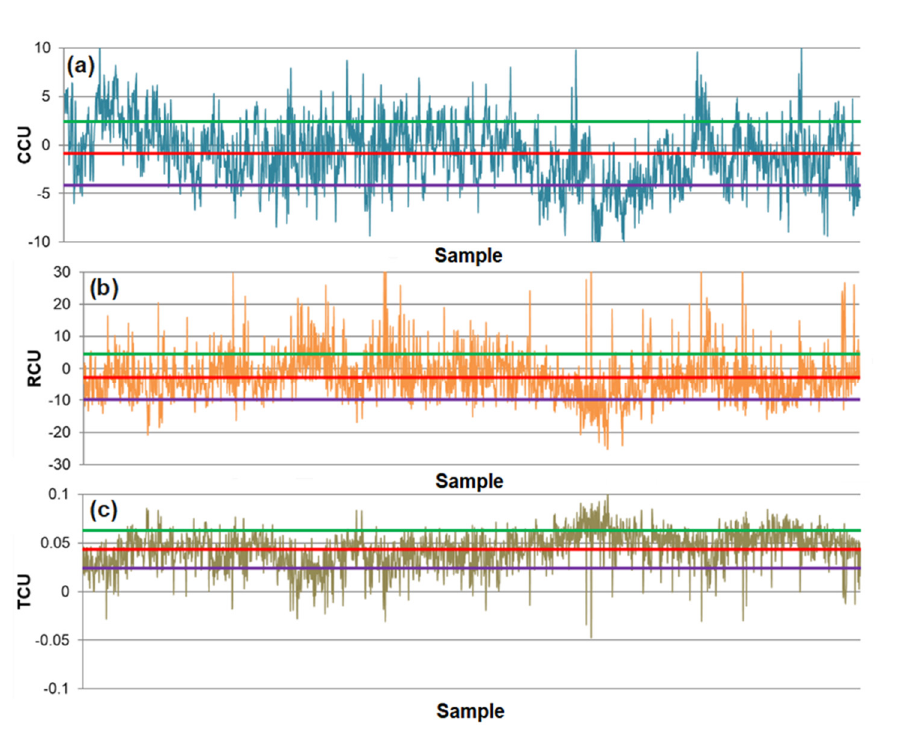
Figure 15. Prediction errors of technological indicators according to the PMM model: ( a ) CCU, ( b ) RCU and ( c ) TCU. The red line on the charts represents mean (μ), green line value μ + 1 SDE and purple line value μ − 1 SDE.